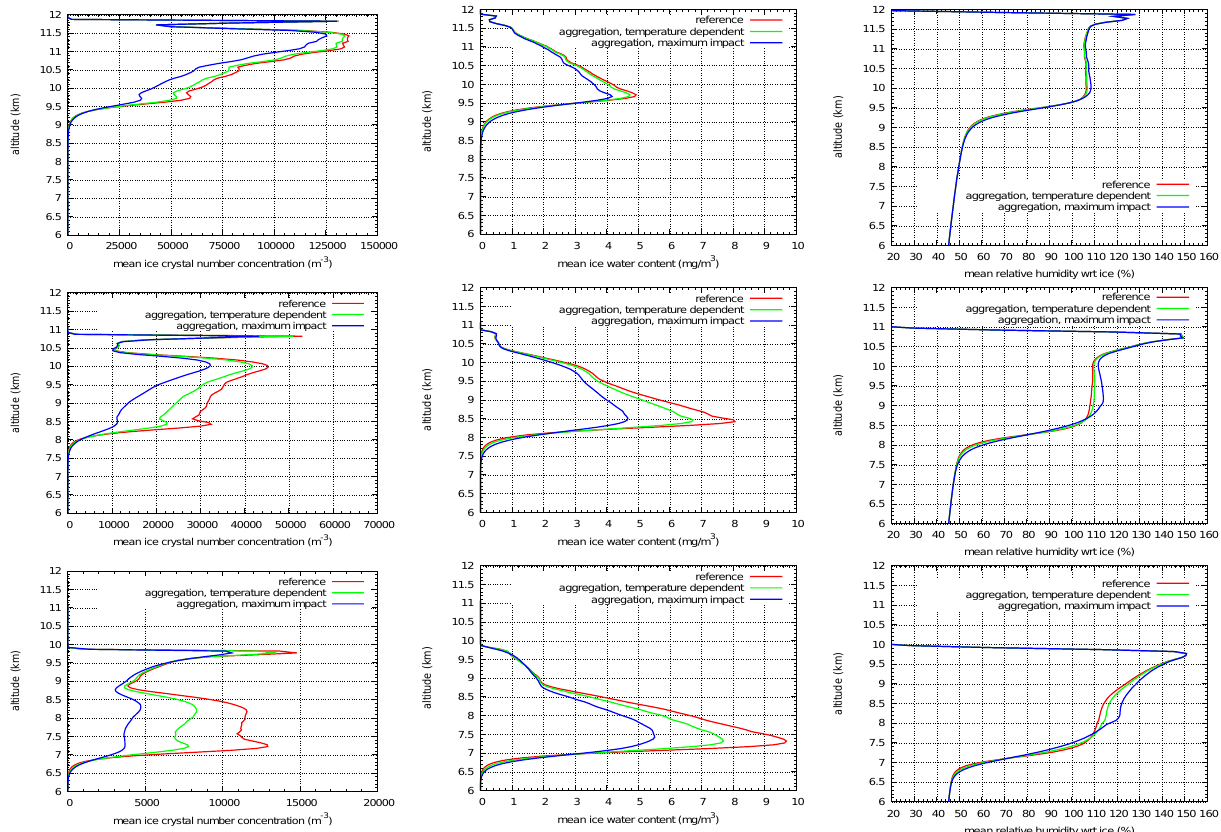
Fig. 10. Vertical profiles of mean ice crystal number concentration (left), ice water content (middle) and relative humidity wrt ice (right) at the end of the simulation ( t = 240 min, w = 5cm s − 1 ) for different temperature regimes. Top row: low temperature conditions, middle row: medium temperature conditions, bottom row: high temperature conditions